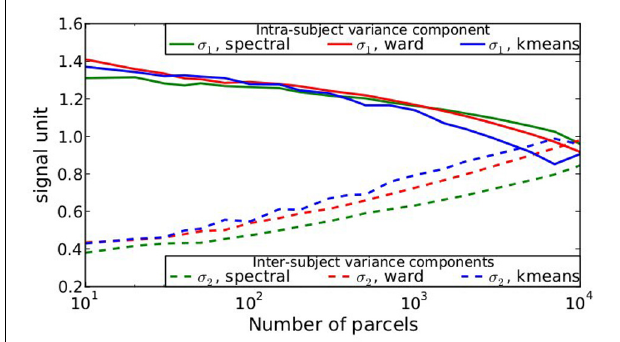
FIGURE 5 | Dependence on K of the variance components from model (Equation 6), averaged across parcels and contrasts: both σ 1 and σ 2 parameters show a monotonic behavior: the within subject variance decreases σ 1 with K , while the between-subject variance σ 2 increases with K .